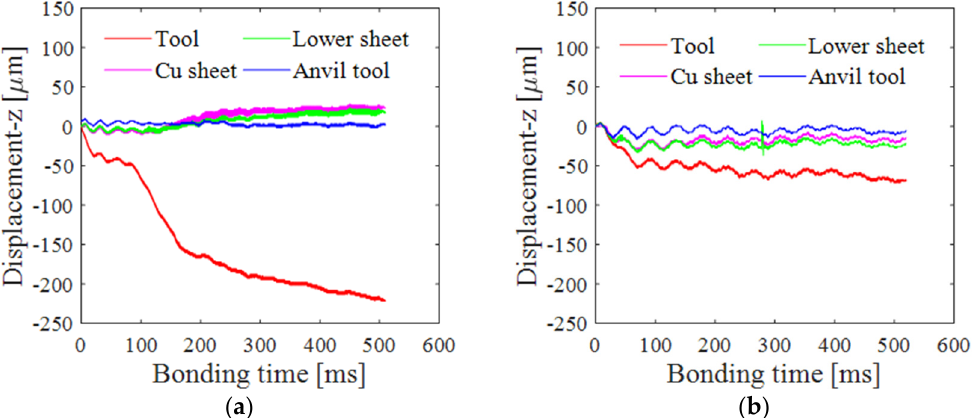
Figure 9. Displacement in the normal direction ( z -axis) ( a ) using the K-type tool and ( b ) using the C-type tool.